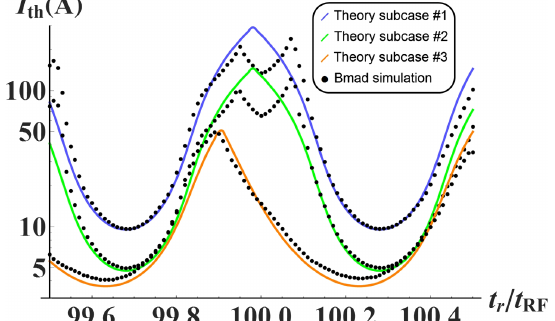
FIG. 17. Comparison of the I obtained from the linearized th formula and BMAD simulation for the case C1 (top curve), C2 (middle), and C3 (bottom). The HOM properties are the same as in case A, and the optics are chosen carefully so T 21 11 ¼ − 10 m = ð 1 GeV =c Þ for all the three subcases.